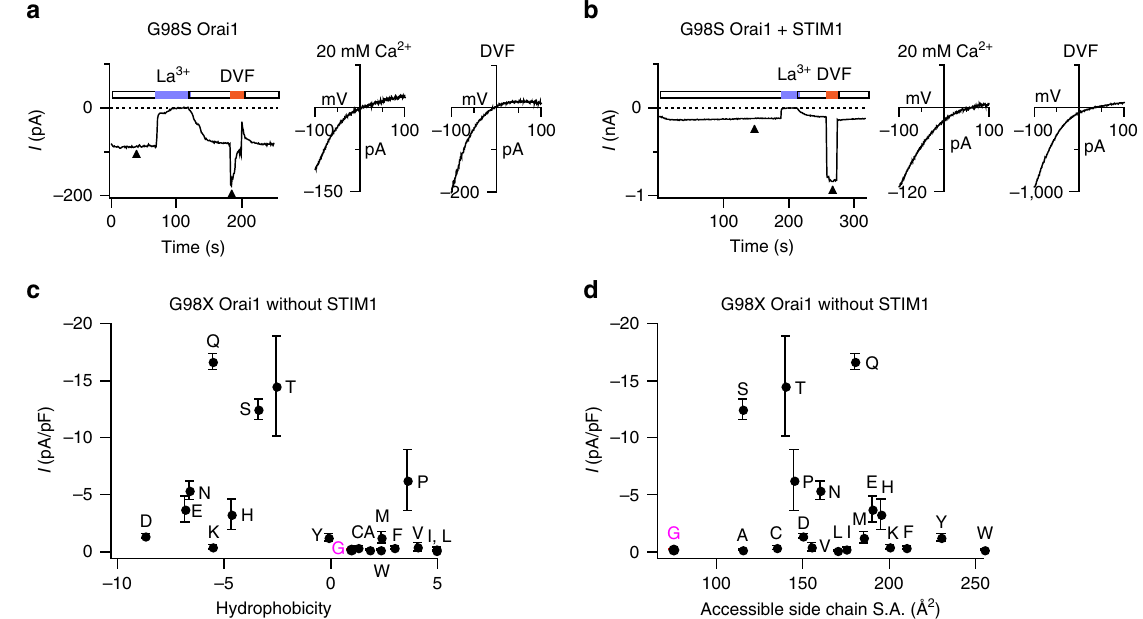
Figure 7 | Polar mutations at G98 cause constitutive Orai1 channel activation. ( a ) Constitutively active G98S Orai1 current seen following whole-cell break-in. The arrowheads indicate the time points at which the I – V relationships of the current are shown in the right graphs. The I – V plots reveal a non-selective cation current permeable to internal Cs þ . G98S Orai1 was expressed in HE293 cells without STIM1. ( b ) Co-expression of STIM1 alters the ion selectivity of G98S Orai1 channels. The I – V plots in 20mM [Ca 2 þ ] 0 and DVF Ringer’s solutions (right) show that V rev is shifted towards positive potentials. ( c ) Mutations at G98 cause STIM-independent constitutive Orai1 activation. The current densities of the indicated G98X mutant are plotted against the solvation energies 38 (kcalmol (cid:2) 1 ) of the introduced amino acids as a measure of their hydrophobicity in the absence of STIM1. Amino acid hydrophobicity increases from left to right. Values are mean ± s.e.m. ( d ) The constitutive activity of G98X mutants plotted against the accessible side-chain surface area. The native Gly residue is depicted in magenta in c and d . n ¼ 3–5 cells for each mutant. Values are mean ±